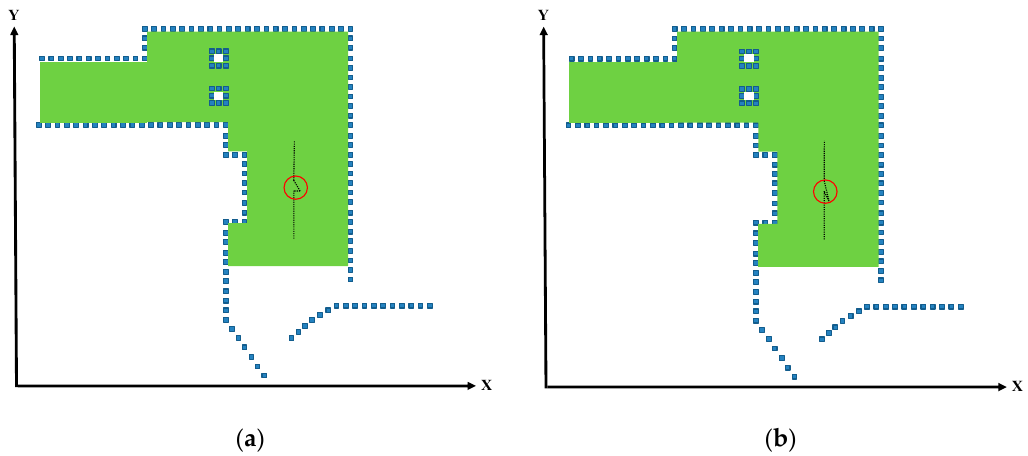
Figure 9. Deviations in window-based localization. ( a ) Sideways deviation in the window-based localization. ( b ) Backwards deviation in the window-based localization.